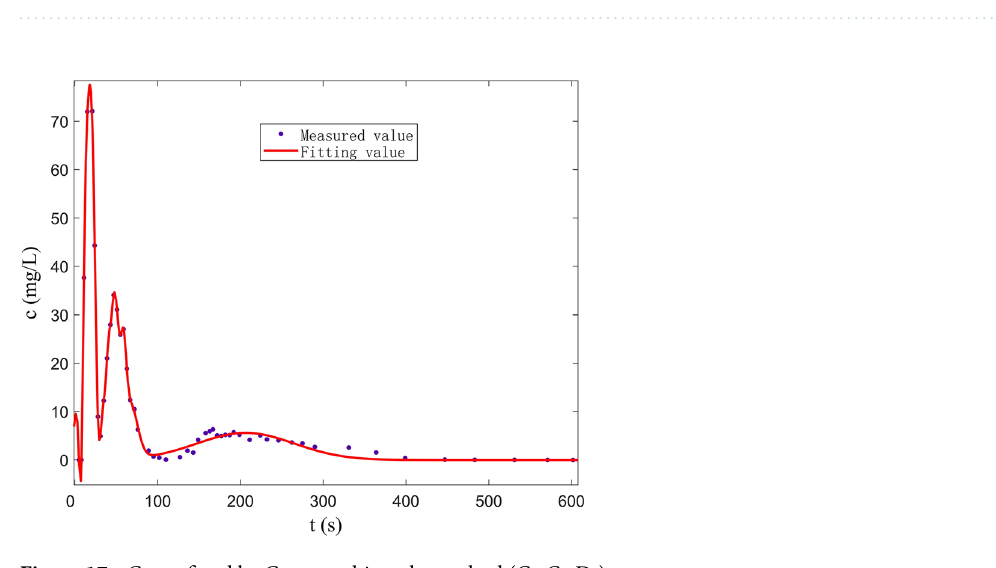
Figure 17. Curve fitted by Gauss multi-peaks method (C 1 -C 2 -D 2